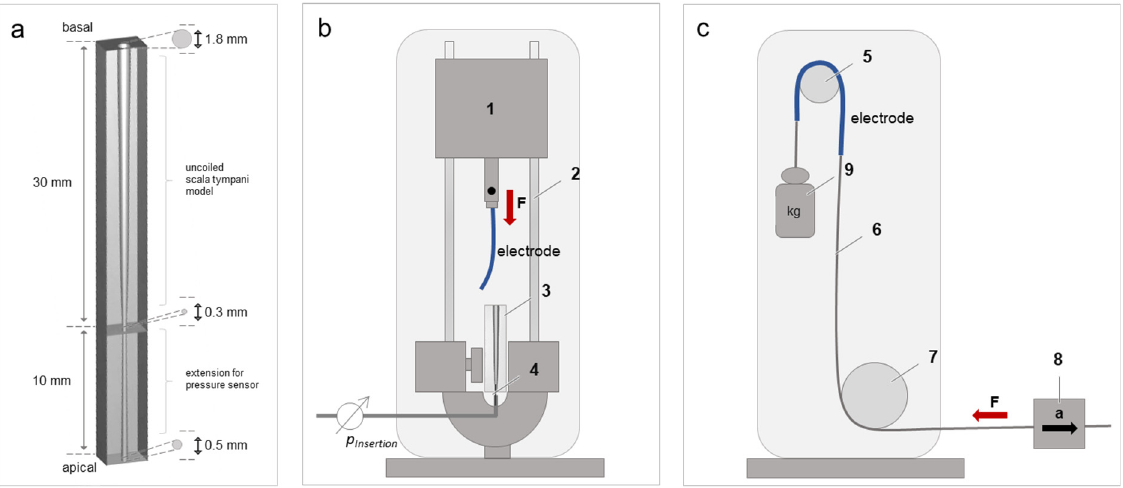
Figure 2. Schematic illustration of the test benches used to analyze the biomechanical properties of a standard cochlear electrode array. ( a ) Linear cochlea model separated into uncoiled scala tympani model (30 mm) and the extension intended for the pressure sensor (10 mm). The diameters range from 1.8 mm to 0.3 mm (uncoiled scala tympani) and 0.3 mm to 0.5 mm (extension) for the basal to apical openings, respectively. ( b ) Illustration of the insertion force test bench. Insertion pressure test bench comprises the load cell (1), linear feed (2), linear cochlear model (3), cochlea electrode array (electrode), and pressure sensor (4). ( c ) Illustration of the friction force test bench. Friction force test bench comprises the deflection cylinder covered with friction partner (5), wire rope (6), deflection pulley (7), load cell (8), counterweight (9), and cochlear electrode array (electrode). Red arrow with “F” indicates the recorded direction of the friction force, and black arrow with “a” indicates the pulling direction.